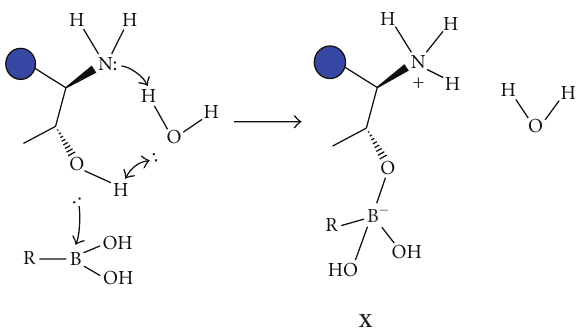
Figure 2: Formation of tetrahedric complex between the hydroxyl group of threonine present on the 20S β 5 subunit of the proteasome and the boronic residue of BTZ . A water molecule is involved in the mechanism of complex formation